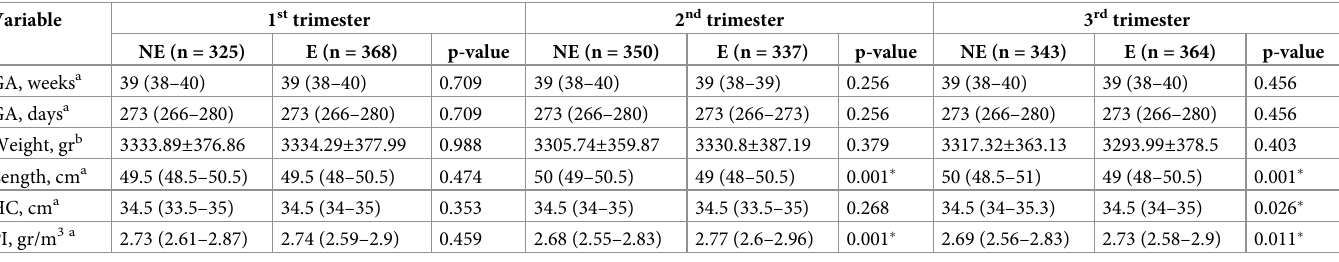
Table 3. Perinatal outcomes of females according to trimester of exposure to